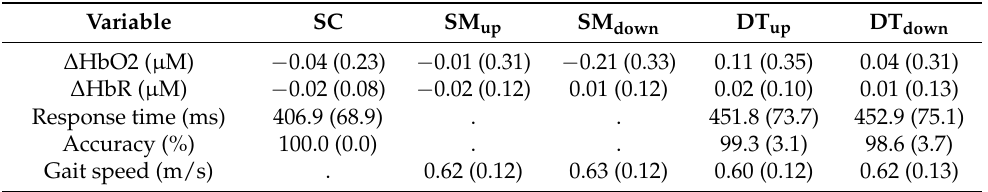
Figure 4. Mean prefrontal hemodynamic response change ( ∆ HbO2) between single motor (SM) and dual-task (DT) blocks. ∆ HbO2 significantly increased from SM to DT; F (1,19) = 6.46, p = 0.020, η ² = 0.254. (*) indicates significance p < 0.05 and error bars represent standard error of the mean. ∆ HbR: A repeated measures ANOVA revealed that there were no significant main effects of SM task ( p = 0.484), stair ascent (DT up ) and descent (DT down ) ( p = 0.851) or interactions between SM, DT up and DT down ( p = 0.549). Similarly, there were no significant differences between SC, DT up and DT down ( p = 0.375) (Table 2). Table 2. Mean and standard deviation values, M ( SD ) for neural, cognitive and performance measures across single and dual-task blocks.